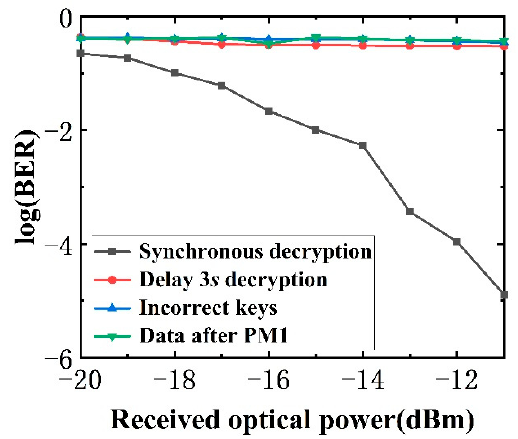
Figure 10. BER performance under different receiver power values.